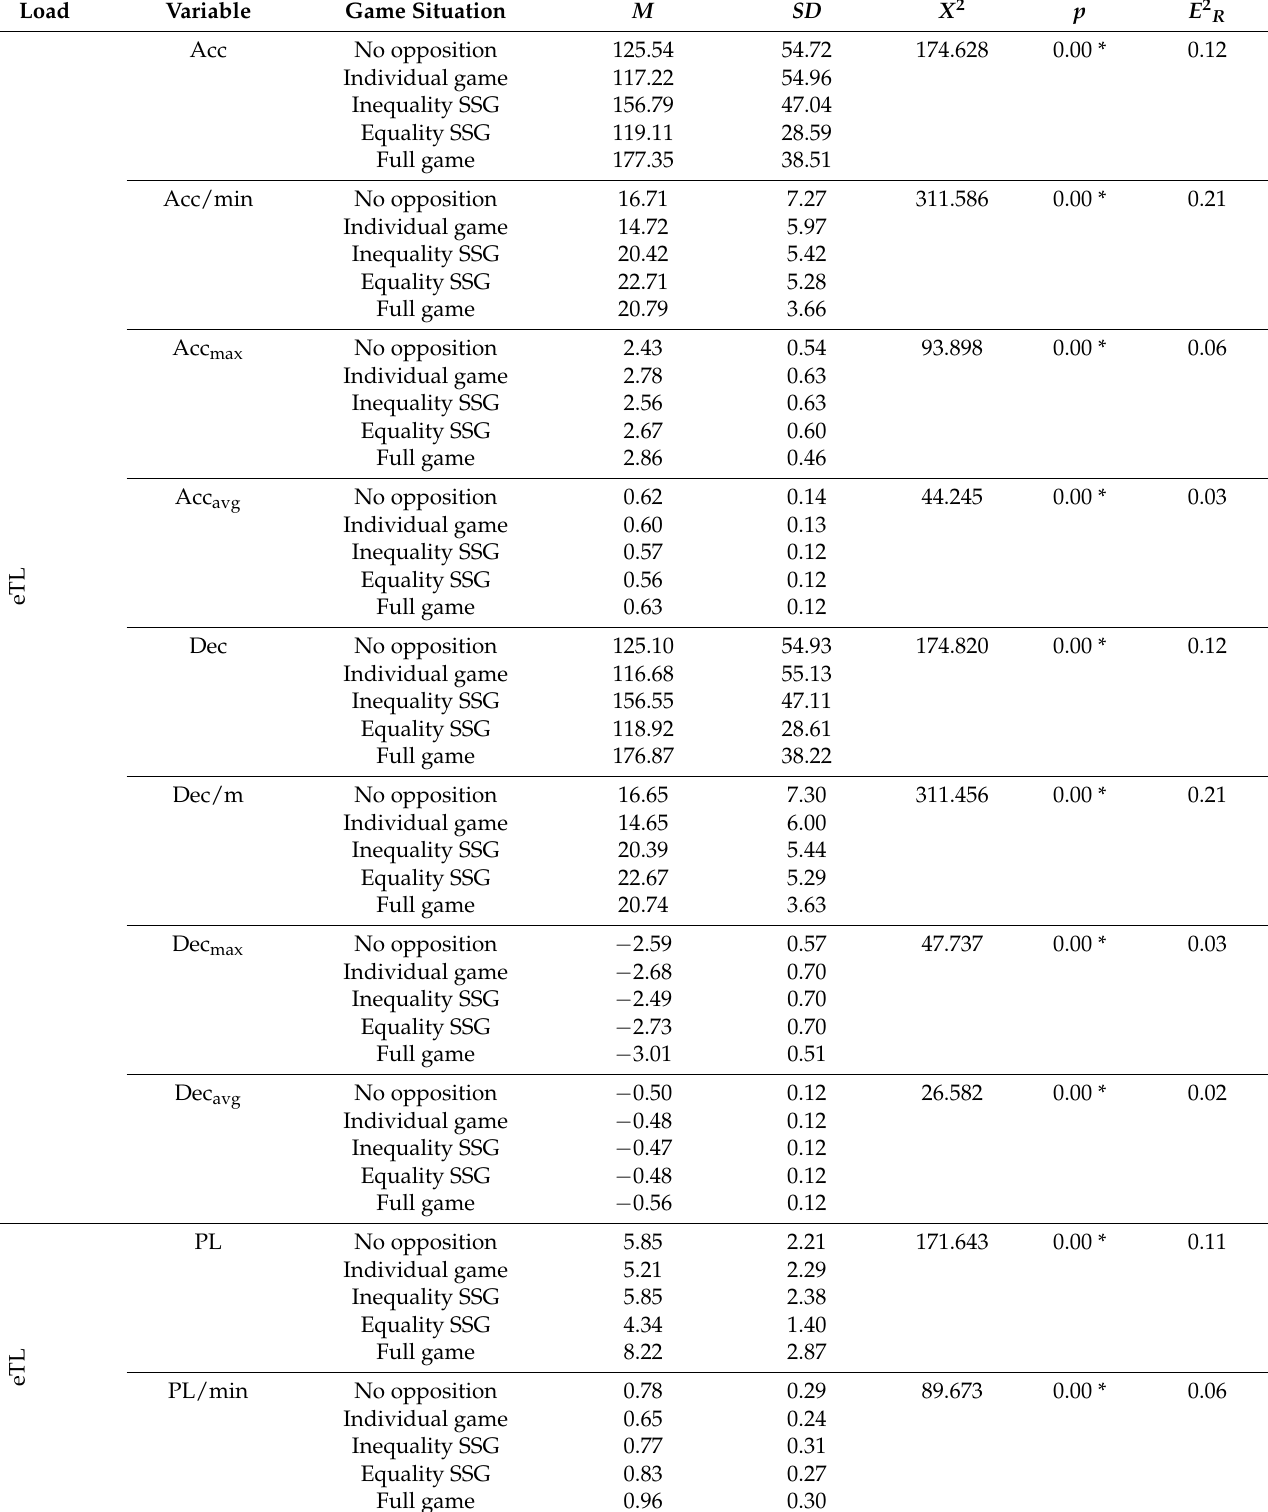
Table 4. Inferential results of the variables studied independently according to the game situation.